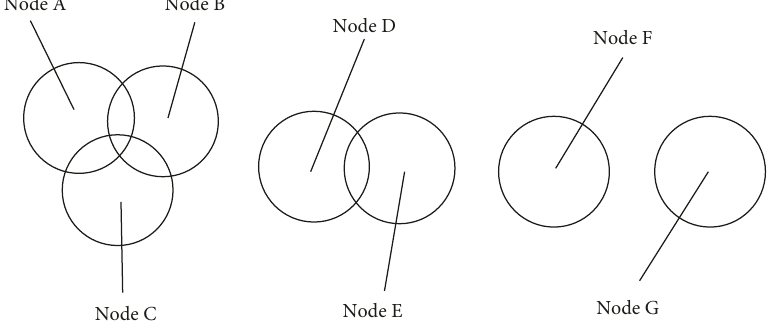
Figure 1: Nodes distribution in wireless sensor networks.